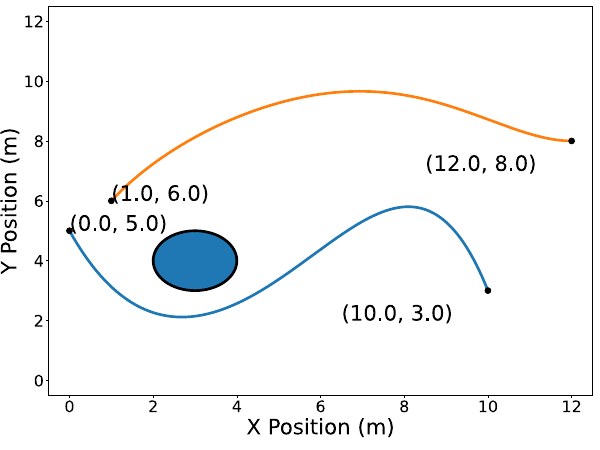
Figure 1. Spatial representation of two Bernstein polynomial trajectories in 2D near a circular obstacle. Trajectory C [ 1 ] ( t ) is drawn in blue and trajectory C [ 2 ] ( t ) is drawn in orange. The solid lines are the polynomials and the dashed lines connect the Bernstein coefficients for convenience. Note that the temporal aspect of the trajectories above has been omitted for clarity of presenting the geometric properties of Bernstein polynomials.